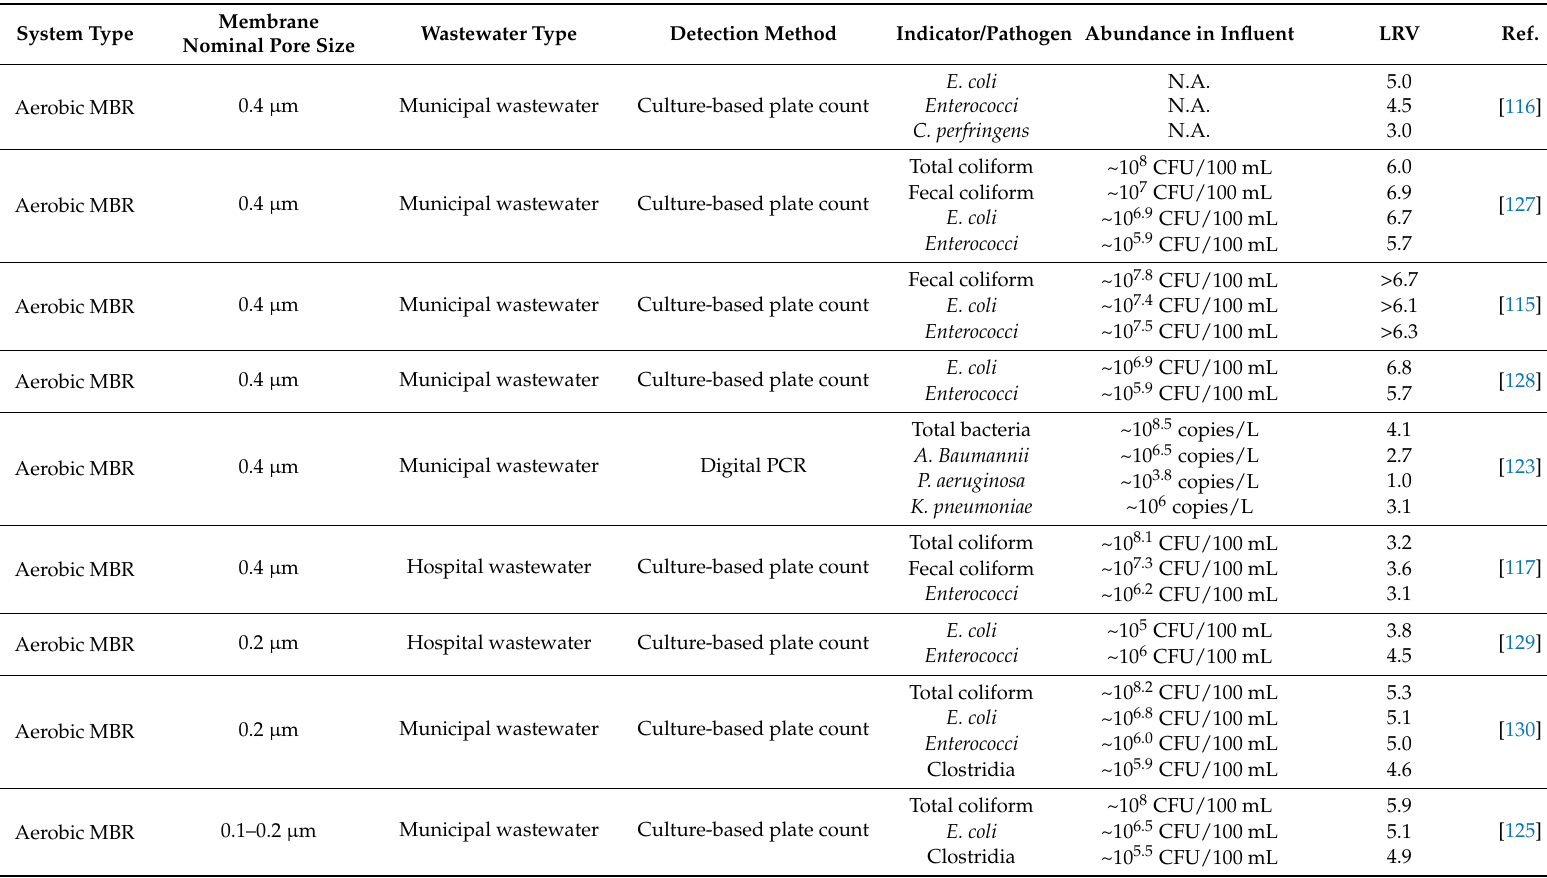
Table 2. Log removal rates of various indicator bacteria and bacterial pathogens in membrane bioreactor systems and their operating conditions. N.A. denotes information not provided. N.D. denotes not